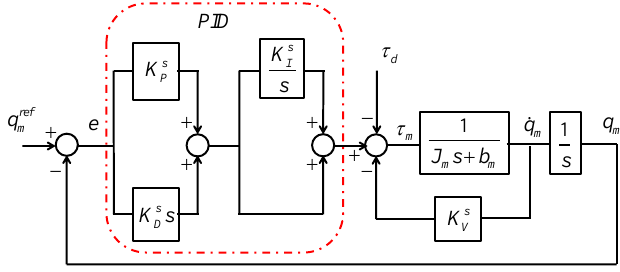
Figure 1. Block diagram of the proposed PID control system with parallel realization.